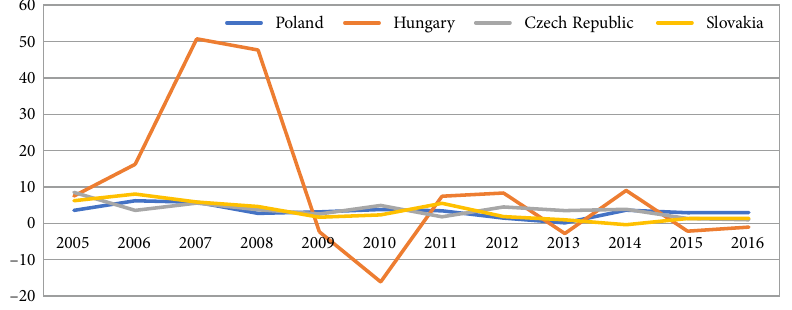
Figure 1. FDI net inflows in V4 countries (% of GDP) (source: own